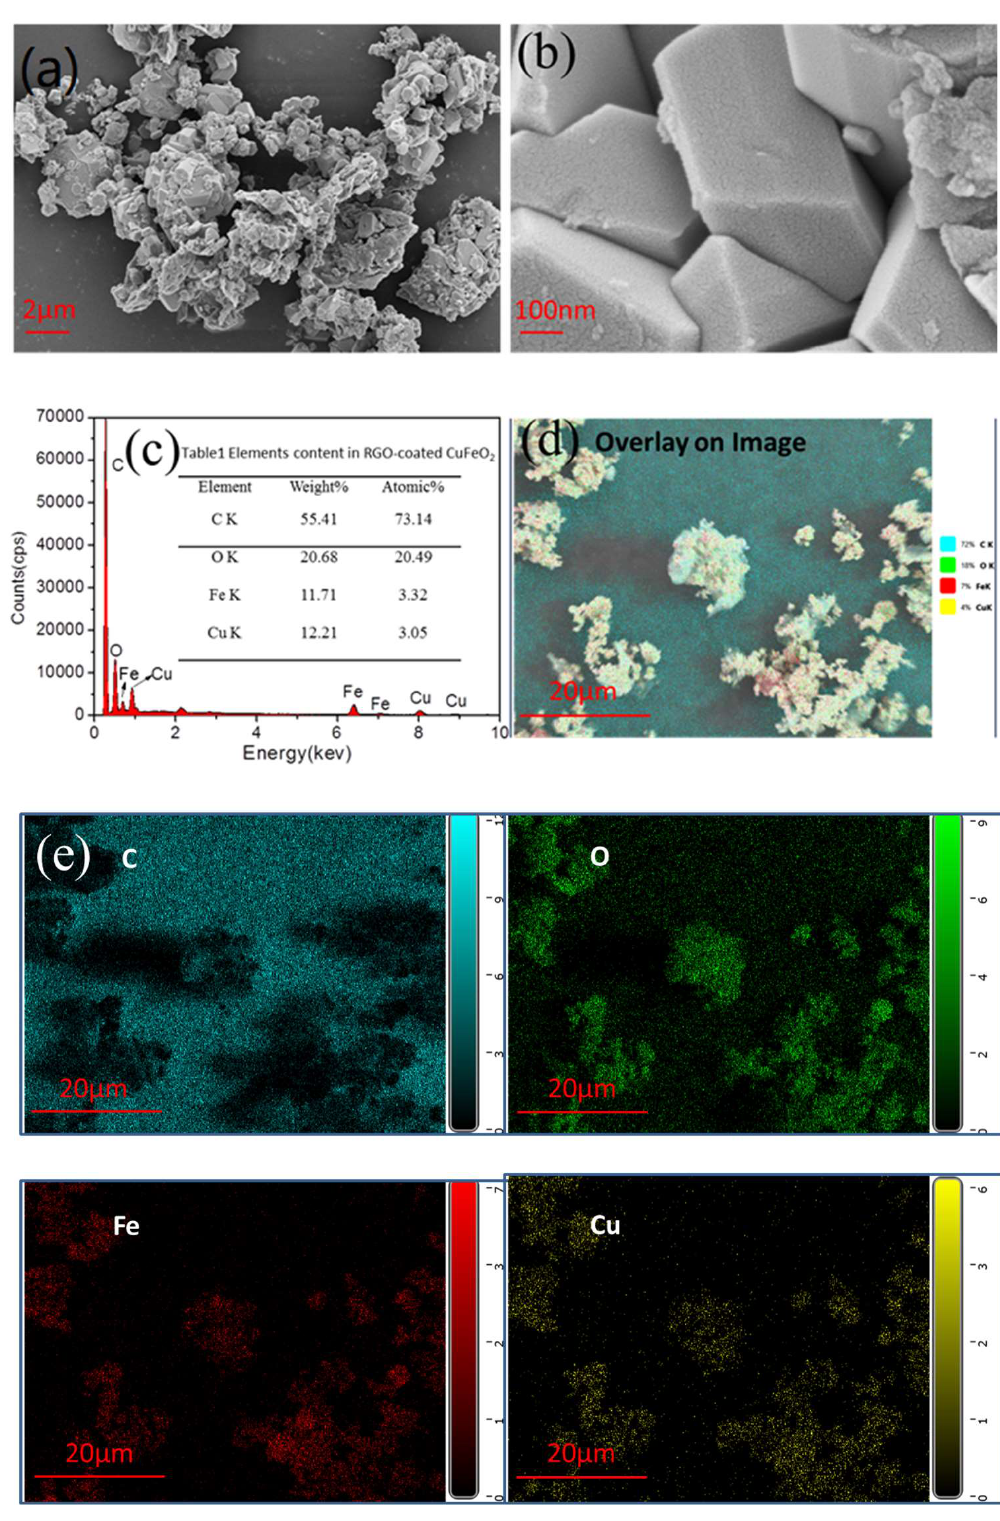
Figure 2. ( a , b ) SEM images; ( c ) EDX spectra; ( d ) the real-time surface distribution map; and ( e ) the elemental mapping images.